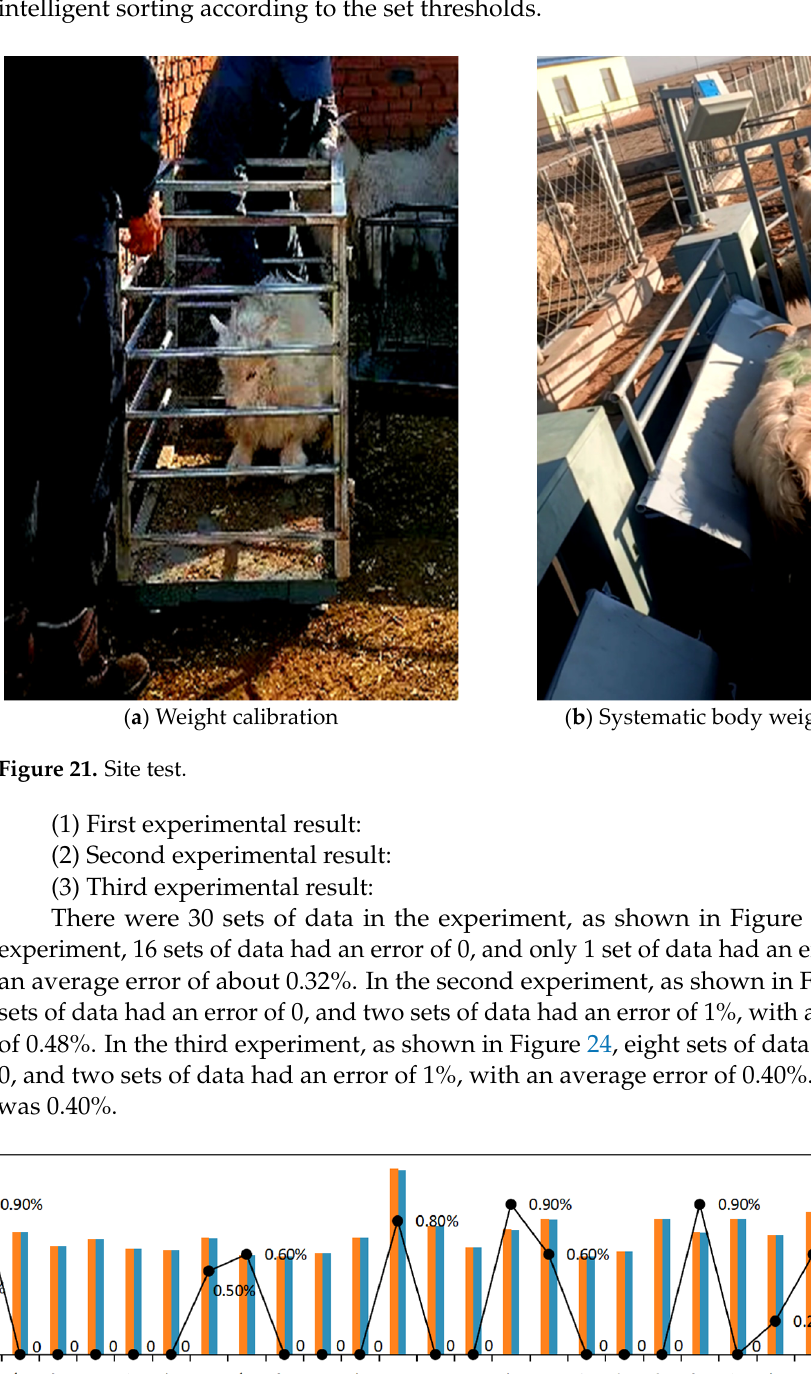
Figure 22. Data plot of the fi rst experiment.